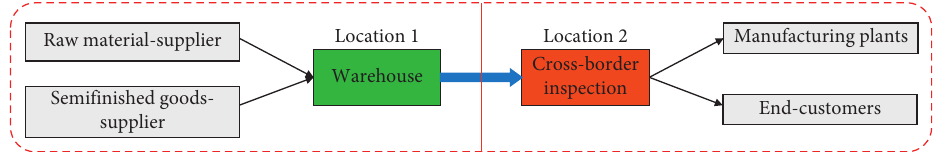
Figure 1: Cross-border supply